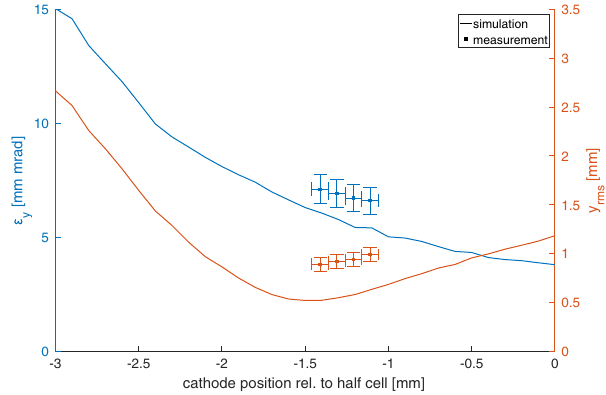
FIG. 15. Measurement of transverse emittance and beam size for different cathode positions for a bunch charge of 120 pC: The measurement was conducted at an accelerating gradient of about 8 MV = m resulting in a kinetic energy of roughly 3.9 MeV. Since during the measurement a strong field emitter was activated, only four positions could be evaluated.